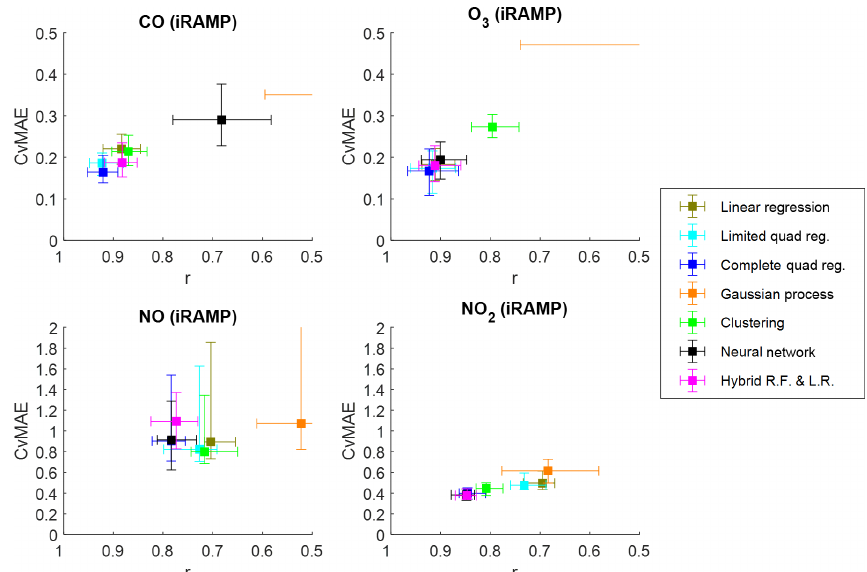
Figure 2. Comparative performance of various individualized RAMP calibration models across gases measured by the RAMPs. Models are trained and tested on distinct subsets of collocation data collected at the CMU site during 2017; performance shown is based on the testing data set only. Proximity to the lower-left corner of each figure indicates better performance. Note the differing vertical axis